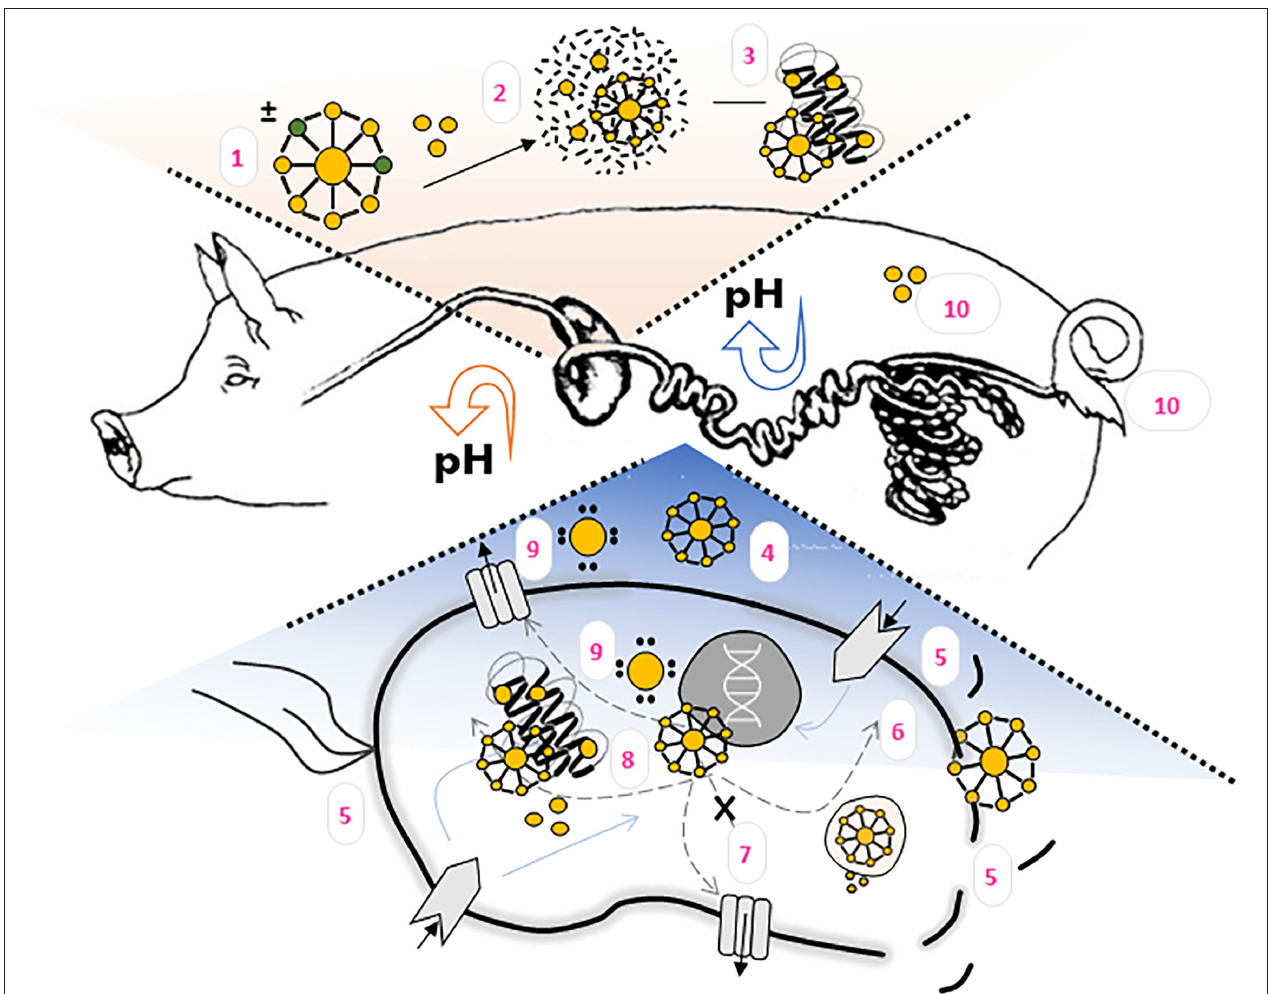
FIGURE 1 | ZnNPs’ fate and proposed mechanism of action in the pigs organism. (1) ZnNPs morphology, size, surface charge and other physico-chemical properties influence its bioavailability, antimicrobial activity, adhesion on epithelial cells, metabolization and (2) Zn 2 + ions release. Both, ZnNPs and Zn 2 + can interact with feed matrix as well as (3) biomolecules. In intestines, where the pH is increasing, ZnNPs or released Zn 2 + ions can disrupt bacterial biofilm (4), influence surface area components, or disrupt bacterial cell membrane (5). ZnNPs are able to penetrate inside bacterial cell (6), where interaction with signaling pahways (7) or bacterial components (8) can occurr. The formation of ROS (9) has been observed either inside or outside bacterial cell. Zn bioaccumulation and excrection should be taken into account when evaluating the effectiveness of the particles (10).